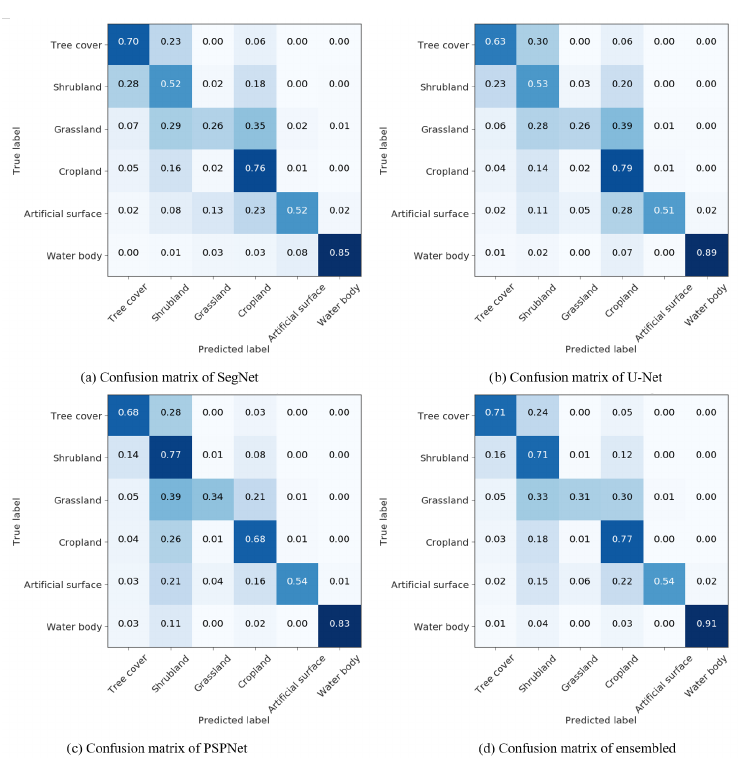
Figure 8. Confusion matrices of the classification results achieved by the Segnet, U-net, PspNet, and merged methods based on the validation